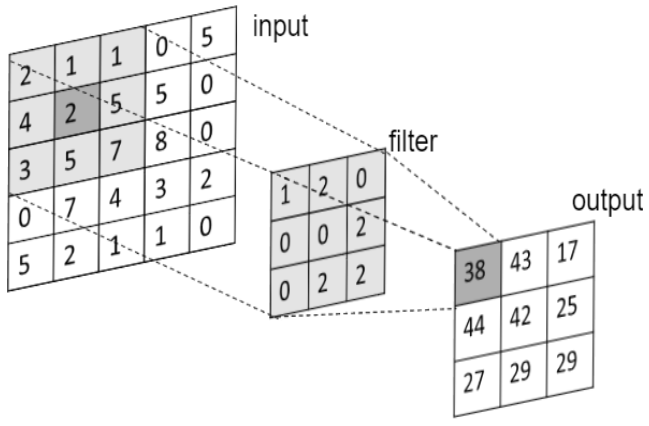
Figure 3. A typical 2D convolution